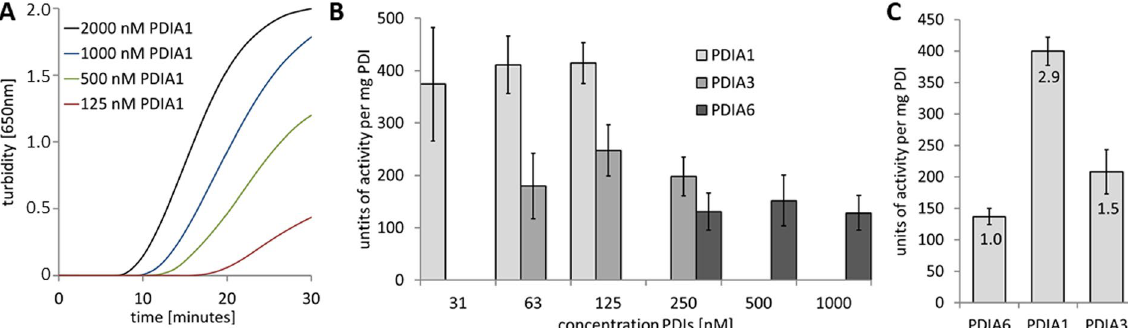
Figure 2. Insulin turbidity assay confirms general differences in the activity of PDIs with regard to disulfide isomerization. ( A ) Time-dependent increase in turbidity as a result of insulin precipitation attributable to the reduction of its disulfide bond catalyzed by PDIA1. The legend gives final PDI concentrations in the assay. ( B ) All three PDIs are able to catalyze the reduction of disulfide bonds in insulin, but higher amounts PDIA3 and PDIA6 than PDIA1 must be applied to obtain maximal precipitation. The indicated concentrations of PDIs were made up in a solution of 1 mg/ml insulin, and the enzyme activity was calculated as described in the methods section. ( C ) Display of the quantification and comparison of the capacities of PDIs to precipitate insulin.